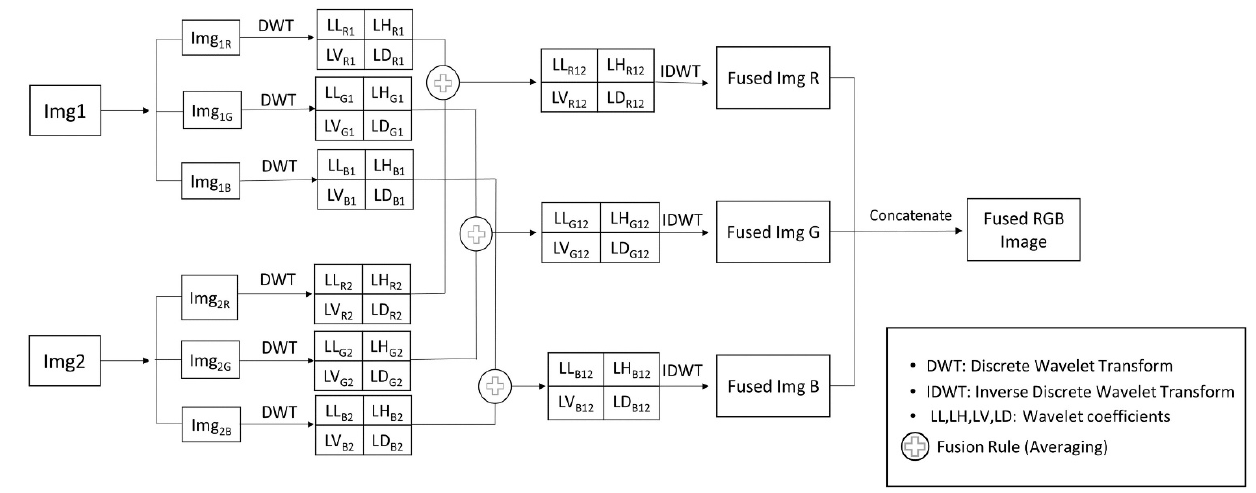
Figure 3. Image fusion schematic illustrating our use of the Discrete Wavelet Transform, with pixel averaging as the fusion rule on the RGB channels of input images.